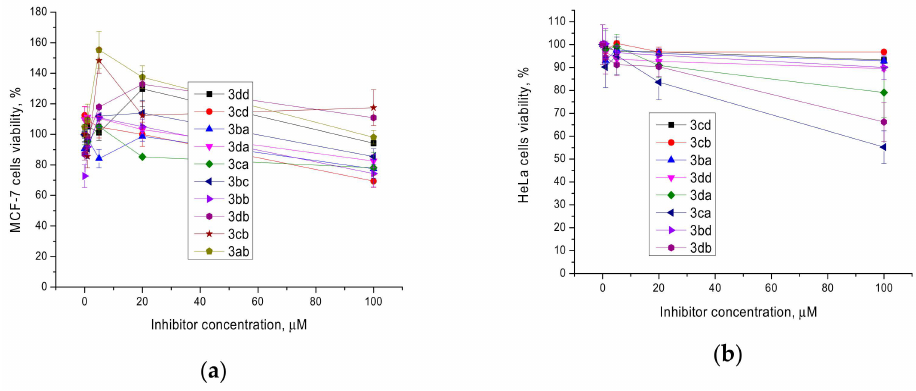
Figure 3. The e ff ect of compounds 3 on the survival of cells of the lines MCF-7 ( a ) and HeLa ( b